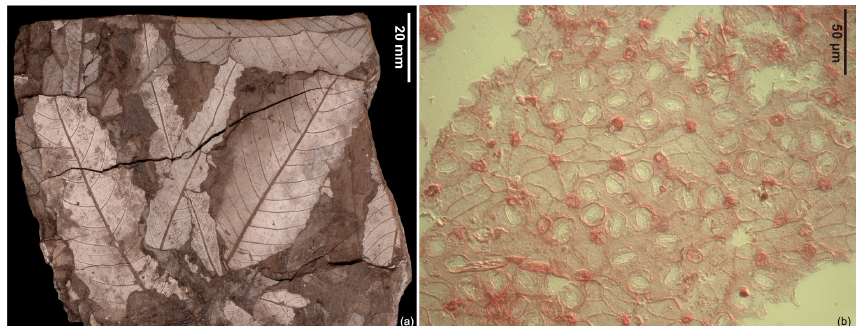
Figure 1. Eotrigonobalanus furcinervis (Rossmässler, 1840; Kvaˇcek and Walther, 1989): (a) mass occurrence of leaves in lignite, Schleen- hain opencast mine, Saxony, Germany, site Schleenhain 2, Borna Formation, Bruckdorf Member, late Eocene (Priabonian), SPP zone 18o, MMG PB SchleOE 535; (b) abaxial leaf cuticle with stomata and trichome bases, Schleenhain opencast mine, Saxony, Germany, site Schleen- hain 4, Böhlen Formation, Gröbers Member, earliest Oligocene (Rupelian), SPP zone 20A/B, slide MMG PB SchleMO 11/05 from leaf SchleMO